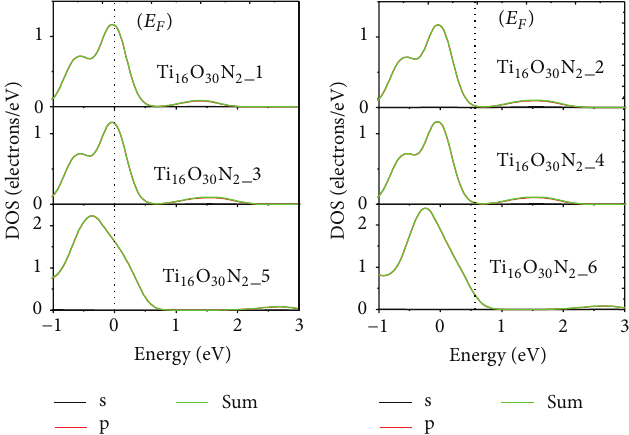
Figure 7: The density of states of neighbors bit N